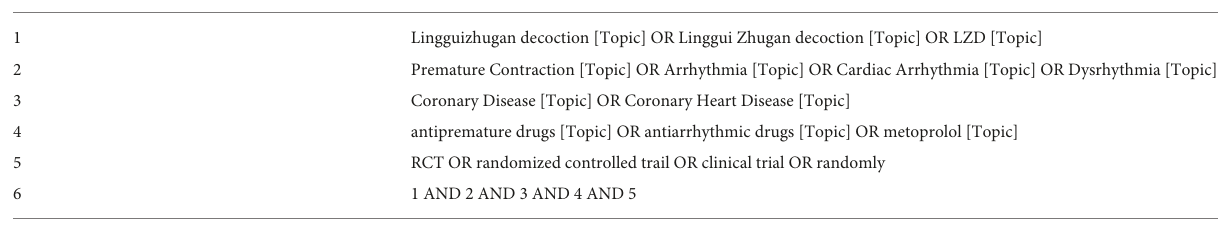
TABLE A6 Web of Science search strategy.